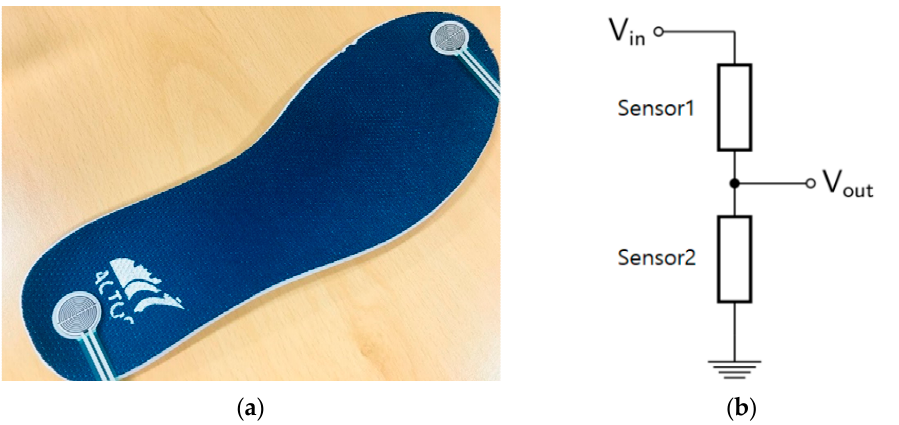
Figure 4. Pressure sensor installation and circuit configuration. ( a ) pressure sensors attached to the insole; and ( b ) voltage divider composed of pressure sensors.